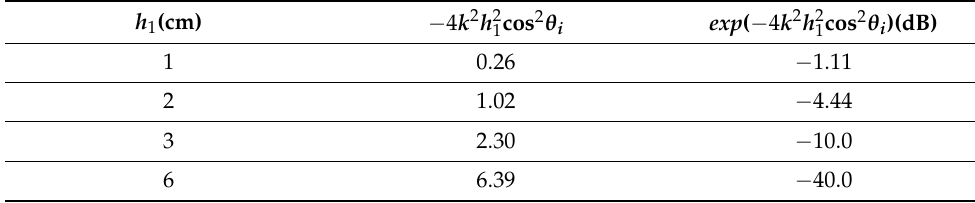
Table 7. Typical values of the attenuation factor in GO-Att. k = 33 m − 1 , θ i = 40 ◦ . h 1 (cm)